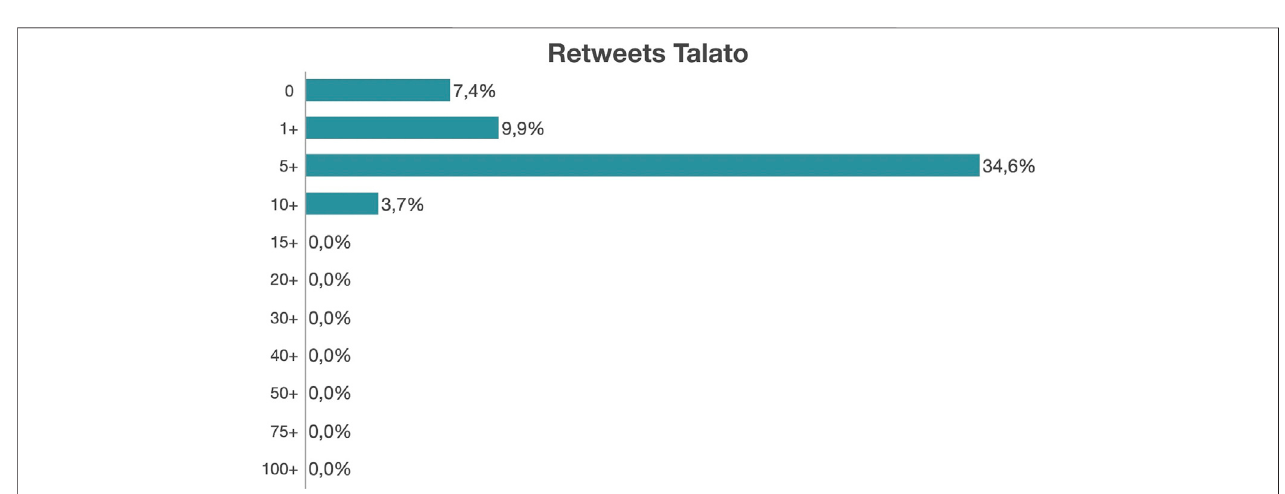
FIGURE 3 | Volume of Retweets of the ABCA posts.